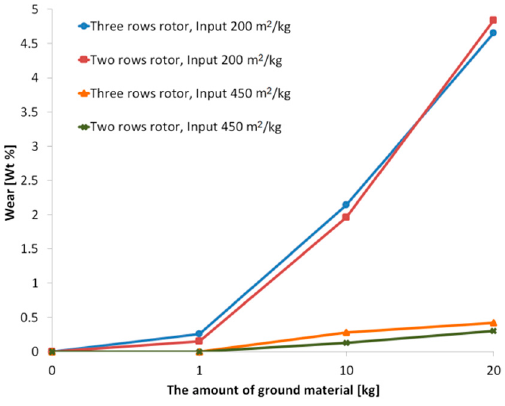
ff ect of the amount of ground material on rotor wear for individual Figure 5. Effect of the amount of ground material on rotor wear for individual samples. Figure 5. E